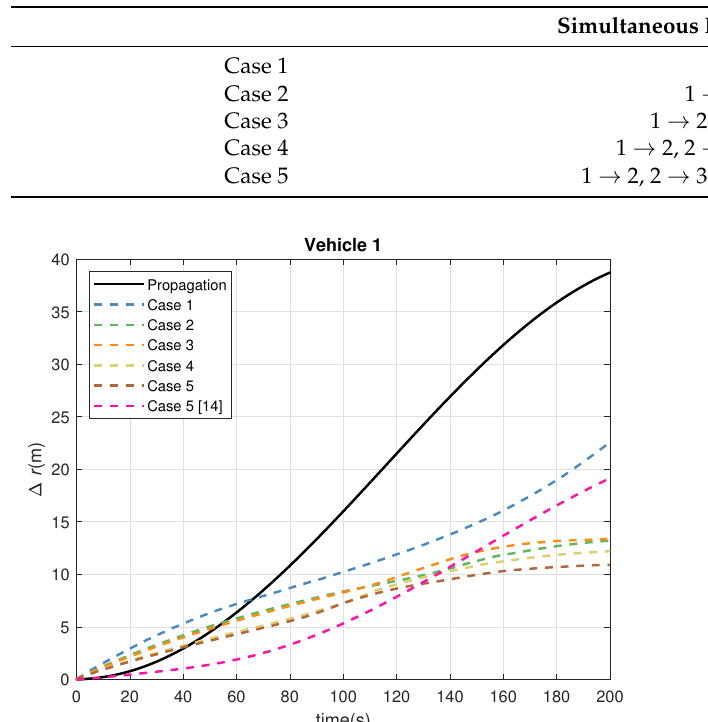
Table 3. Simultaneous measurement descriptions for Scenario 1.